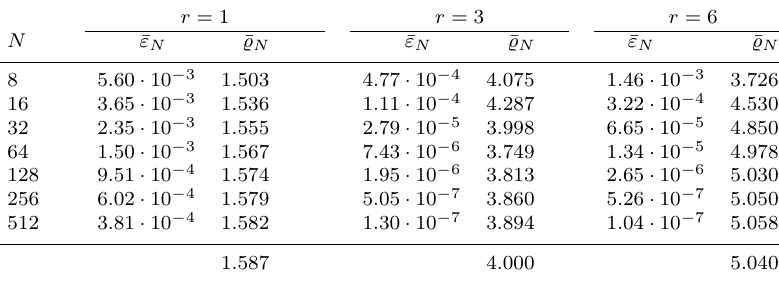
Table 4. Numerical results for problem (6.1)–(6.2) using Method 2, with Gauss collocation points (6.4) and m =